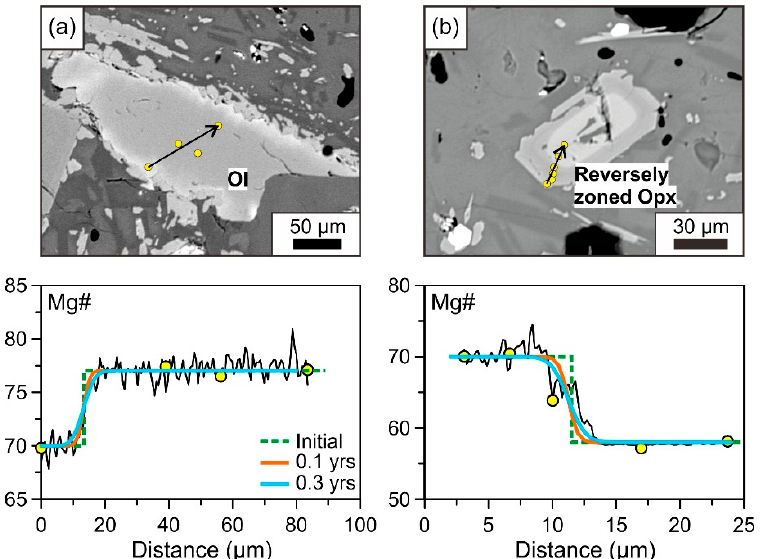
Figure 2. Modeling results of Mg diffusion in the olivine ( a ) and orthopyroxene ( b ) in andesite T5-2. The black curves were obtained from the gray values of BSE images. The yellow spots denote the data obtained by EMPA.